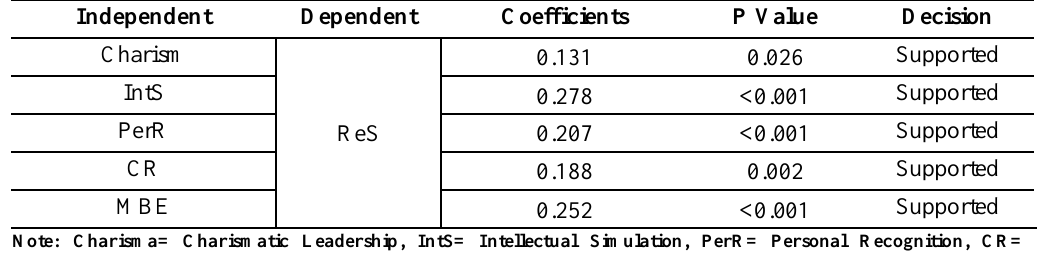
Table.6. Path Coefficients When Resilience is Dependent Independent Dependent Coefficients